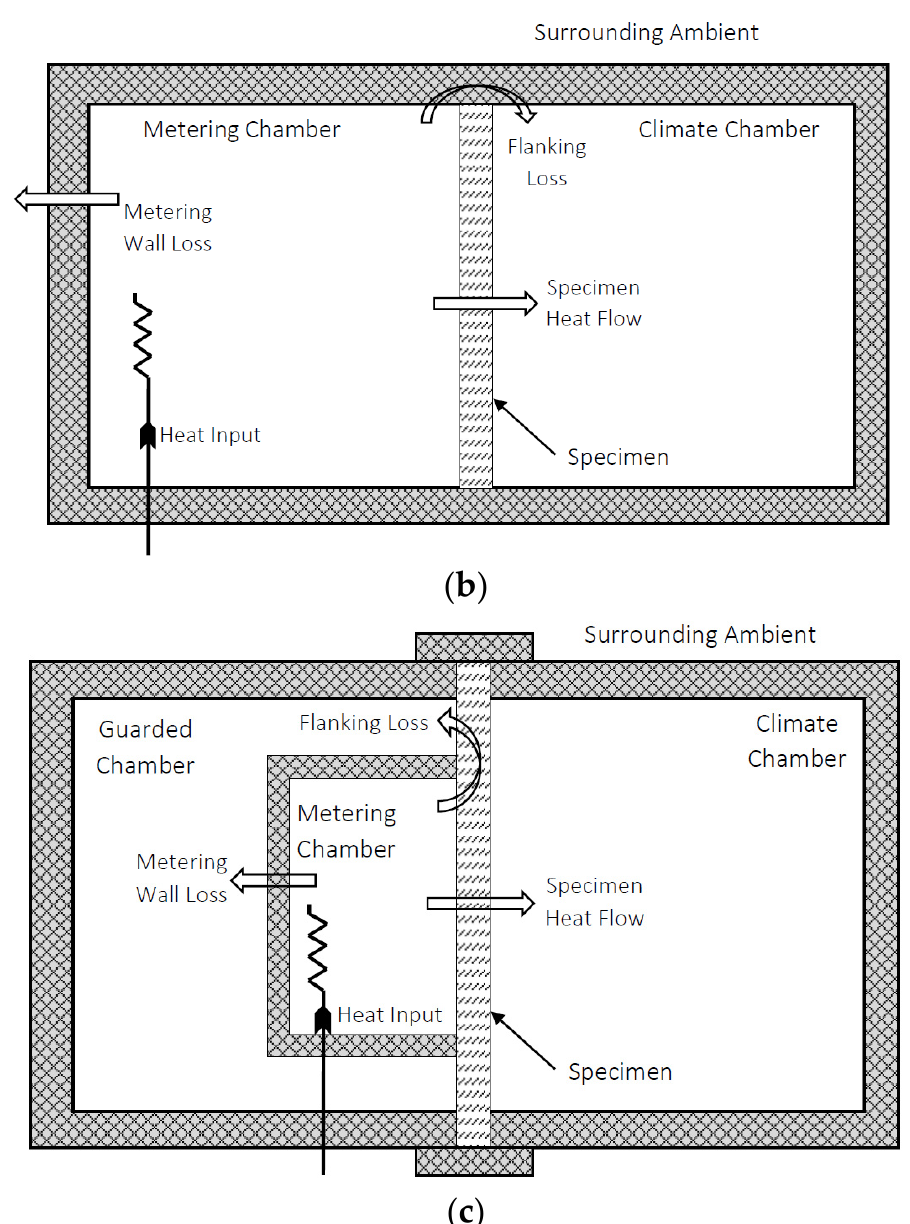
Figure 1. Schematics of: ( a ) guarded hot plate; ( b ) calibrated hot box; ( c ) guarded hot box.